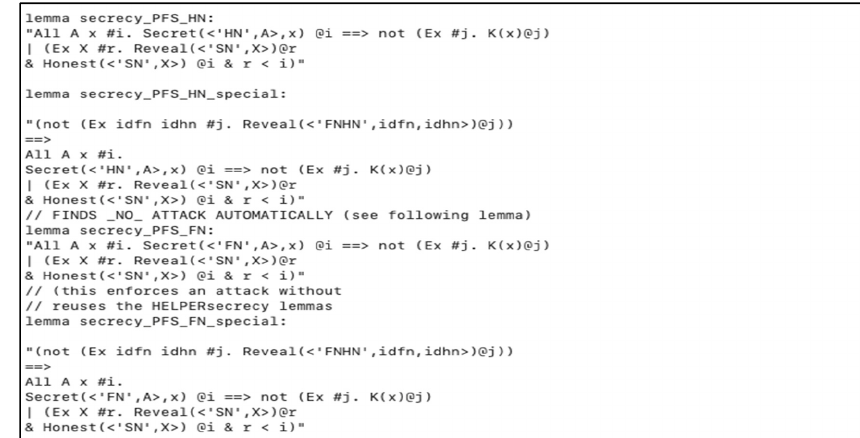
Figure 11. Replay attack resistance lemmas in HN and FN .